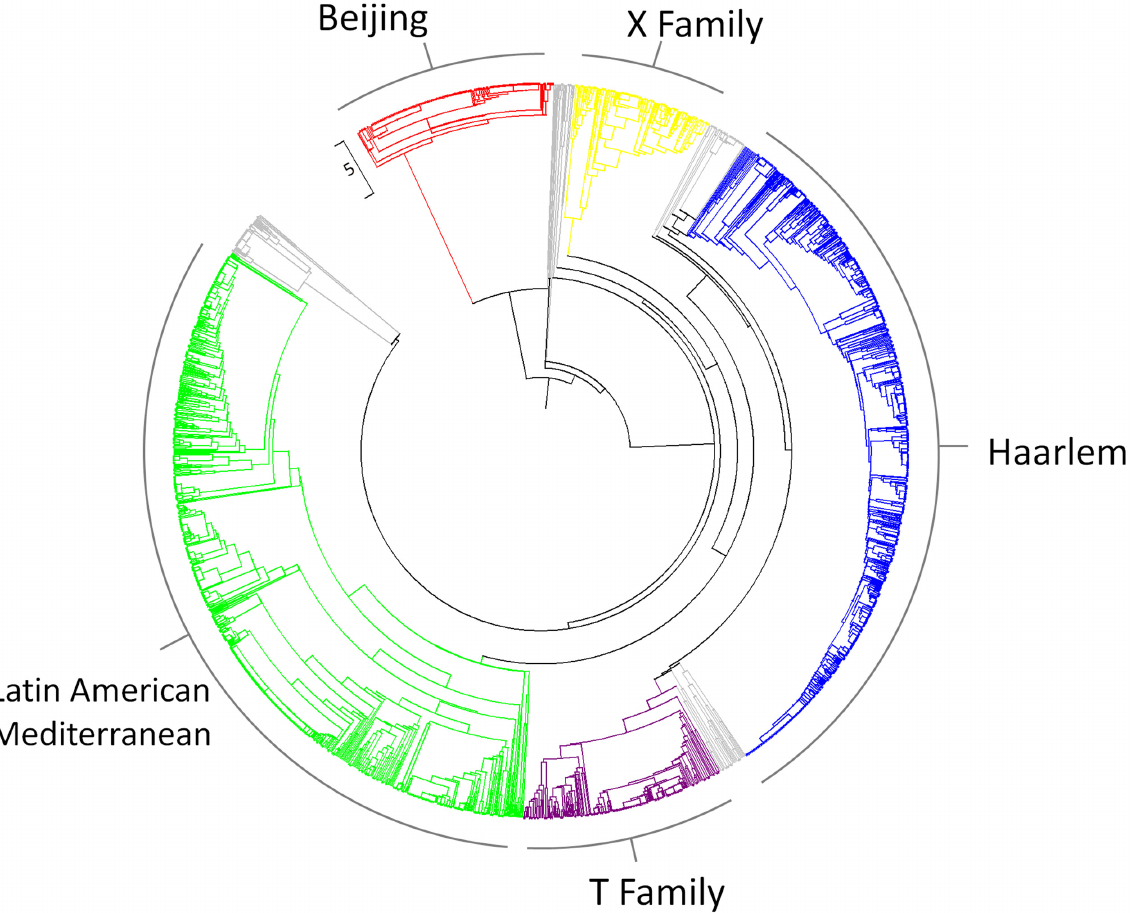
Fig 1. A UPGMA phylogeny of all study strains. Beijing strains coloured red, X clade coloured yellow, Haarlem clade blue, T clade purple and Latin American Mediterranean green. Strains belonging to other families and strains that could not be subscribed a family as they were too distant from strains in the MIRU-VNTRplus database are shown in